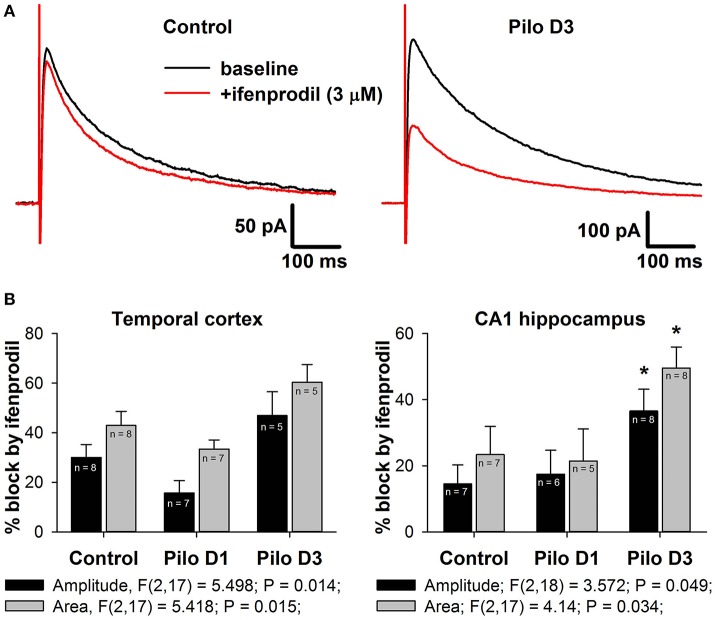
Effects of a selective GluN2B-containg NMDAR antagonist ifenprodil on evoked NMDAR-mediated synaptic currents. (A) Representative examples of recordings in hippocampal pyramidal neurons of control and PILO-rats. Black trace—the averaged initial synaptic response, red trace—the averaged synaptic response after application of ifenprodil. (B) Diagrams illustrating the block of current peak amplitude (black bars) and response area (gray bars) of NMDAR-mediated synaptic currents in pyramidal cells of control and PILO-rats. One-way ANOVA results are presented below the charts. Asterisks indicate significant difference (p < 0.05) from the control group (multiple comparisons vs. control group, Dunnett's test).